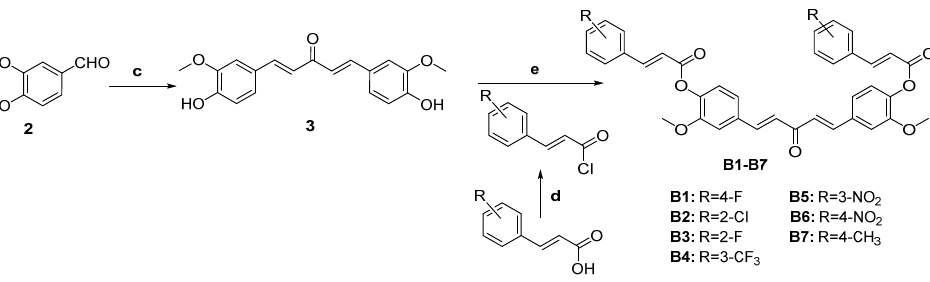
Scheme 2. Synthesis of the curcumin analogs B1–B7 . Reagents and conditions: ( c ) acetone, aqueous NaOH, ethanol, 48 h; ( d ) SOCl 2 , 80 °C, reflux, 2 h; ( e ) CHCl 3 , triethylamine, 0 °C to room temperature, 12 h.